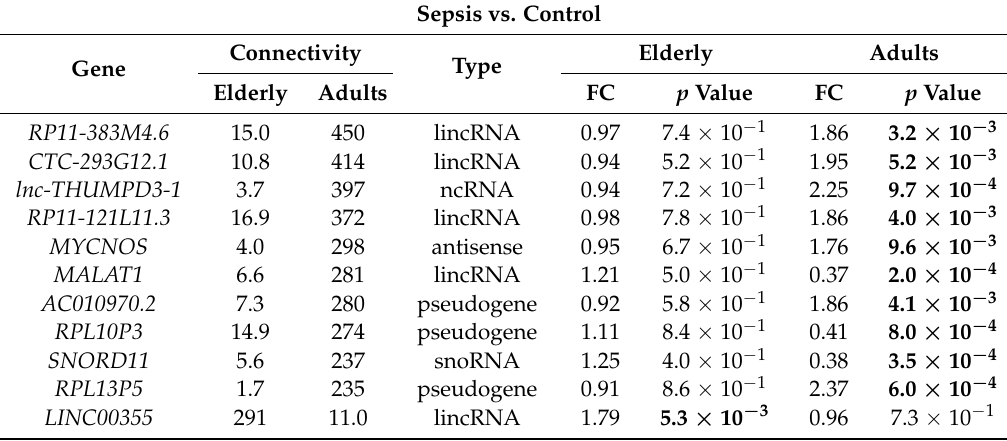
Table 3. Selected lncRNAs among the most differentially connected (top 20%) DEGs between co-expression networks from elderly and adults that show an average local similarity greater than the median similarity of enriched pathways related to cellular respiration in at least one network, and show an inverted expression pattern between networks. The average fold-changes (FCs) between sepsis and control subjects for each age group are shown. Significant p values are in